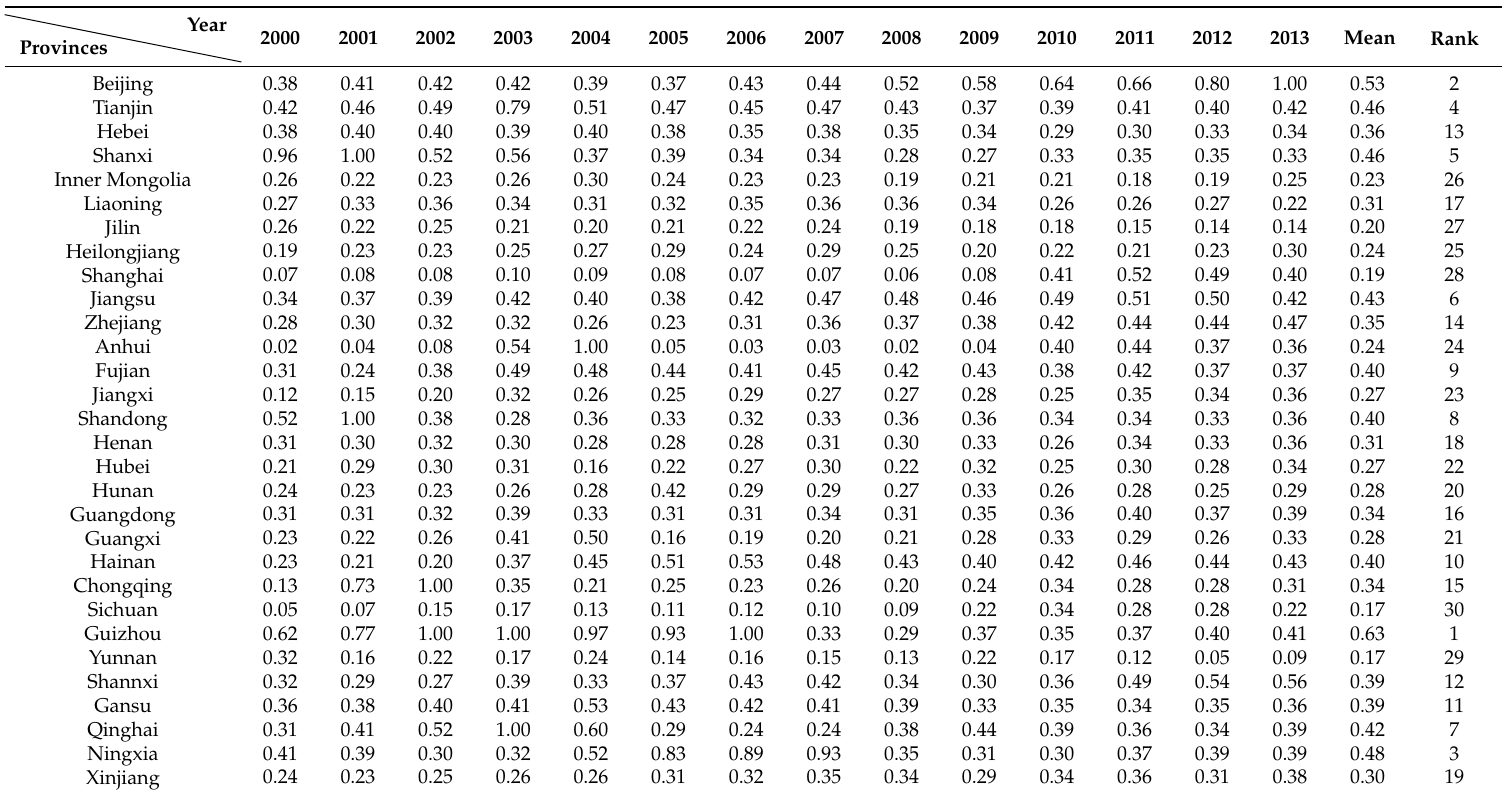
Table 6. Mean environmental efficiency scores for 30 provincial power grids,